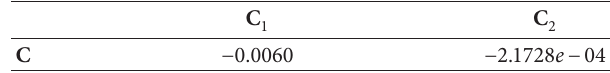
( i � 1 , 2 ) ; (c, e) the differences i Table 6: Encryption key sensitivity